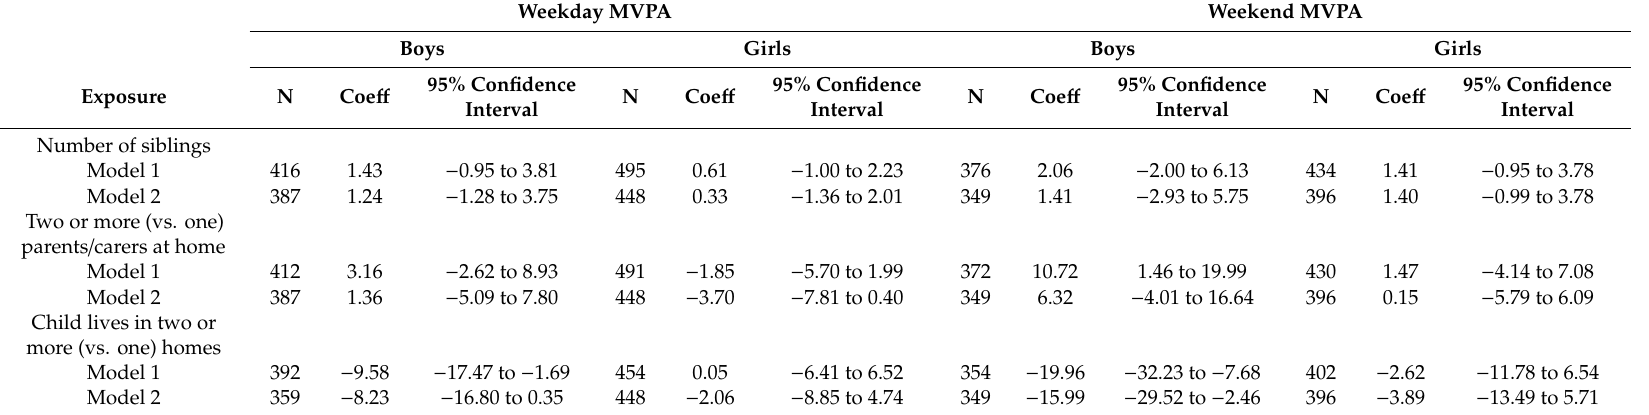
Table 4. Cross-sectional associations of weekday and weekend MVPA with family structure variables at age 11. Weekday